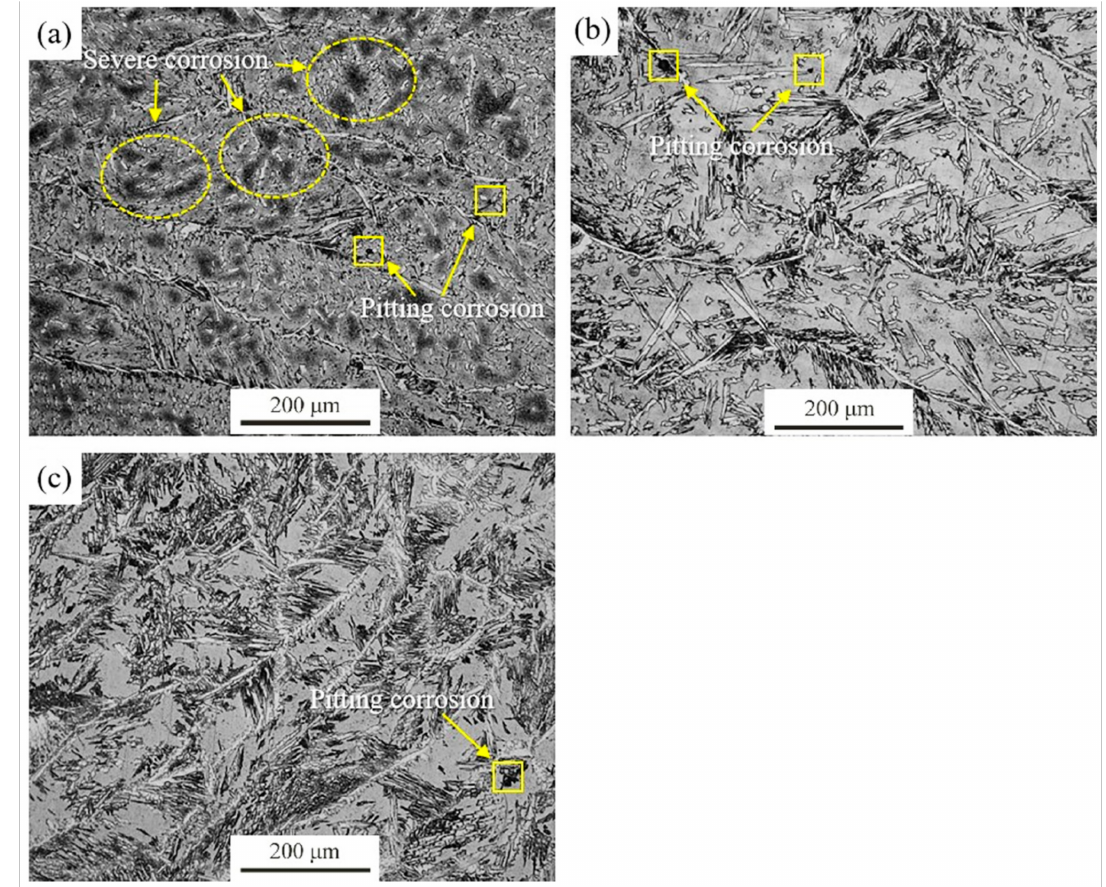
Figure 12. Metallographic structure of the welded joints under different shielding gases after DL-EPR test ( a ) 1#-Ar; ( b ) 2#-98%Ar + 2%O 2 ; ( c ) 3#-98%Ar + 2%N 2